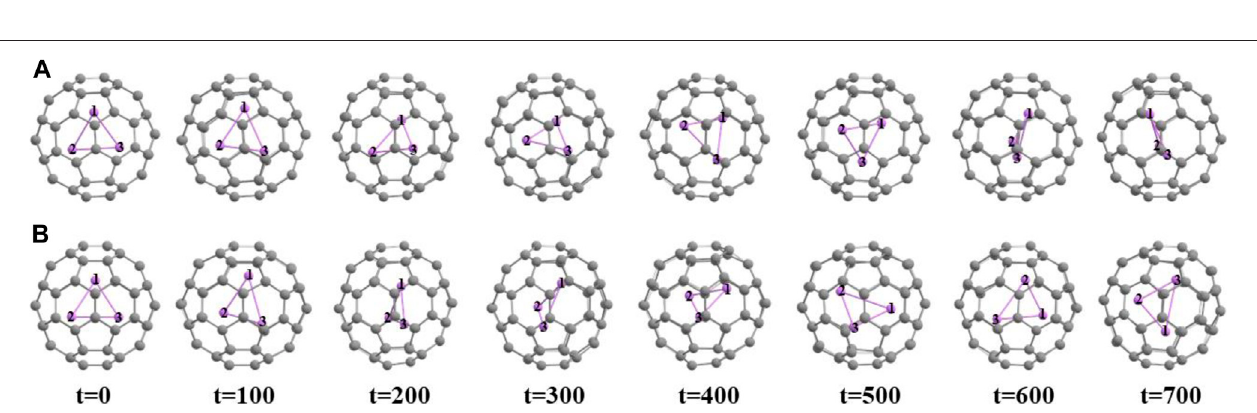
FIGURE 5 | Snapshots at different time steps (time in fs) (A) at 300 K temperature, (B) at 500 K temperature of Li 3 @C 60